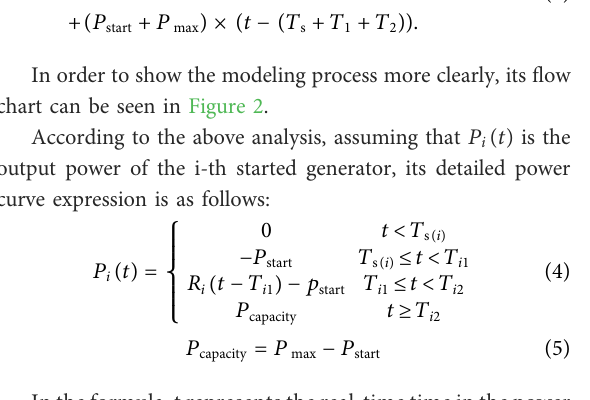
FIGURE 2 Flow chart of the restoration model for